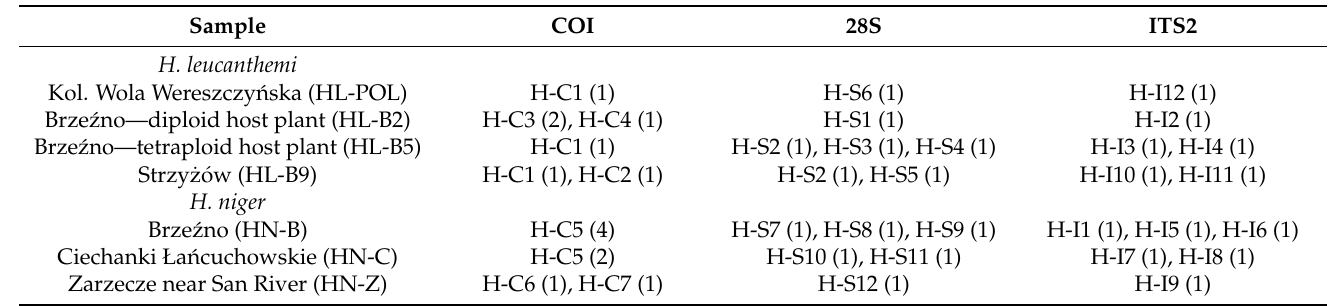
Table 2. Distribution of mitochondrial and nuclear haplotypes identified among sequences obtained for tested H. leucanthemi and H. niger individuals. Numbers in brackets indicate numbers of sequences identified as particular